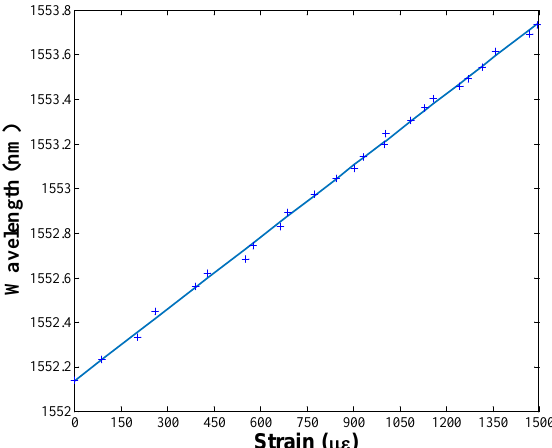
Figure 9. Strain sensitivity of the EDSCL. The whole erbium doped fiber ring laser (EDFRL) sensor exhibits the same sensitivity as the FBG employed to select the lasing wavelength.